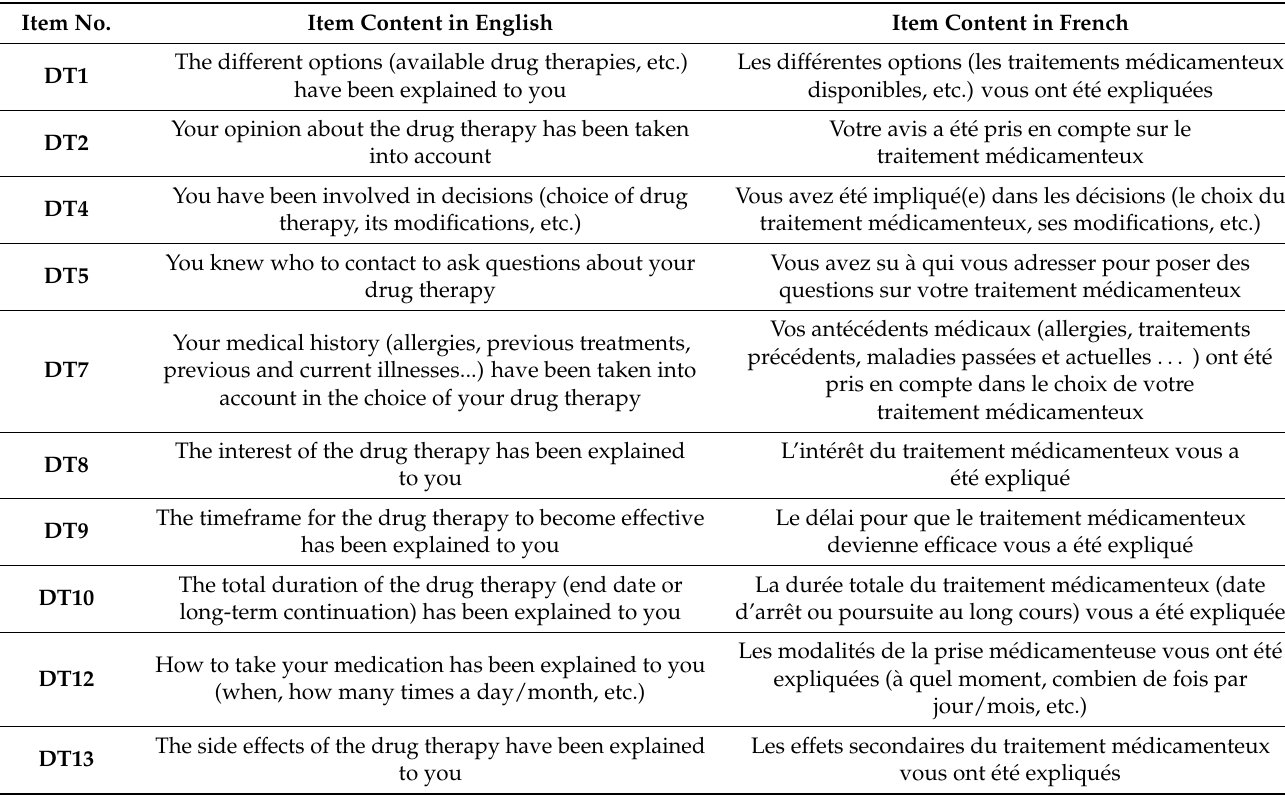
Table A3. List of the 26 items of the PREMIUM-DT item bank (English and French